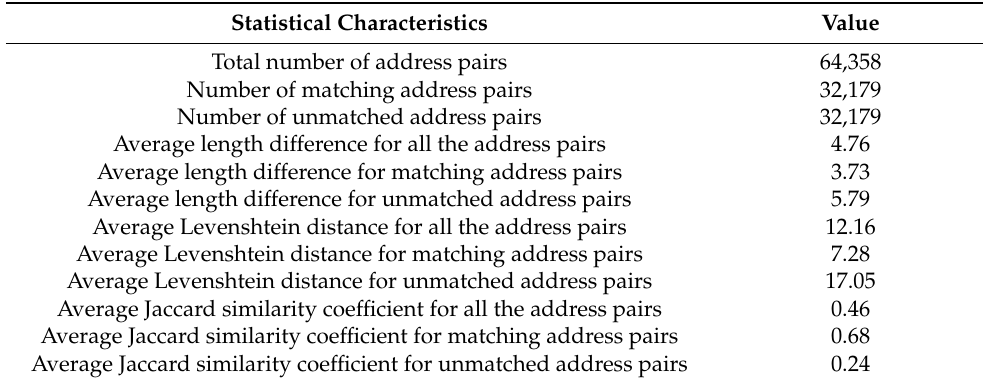
Table 2. Statistical characteristics of the labelled address